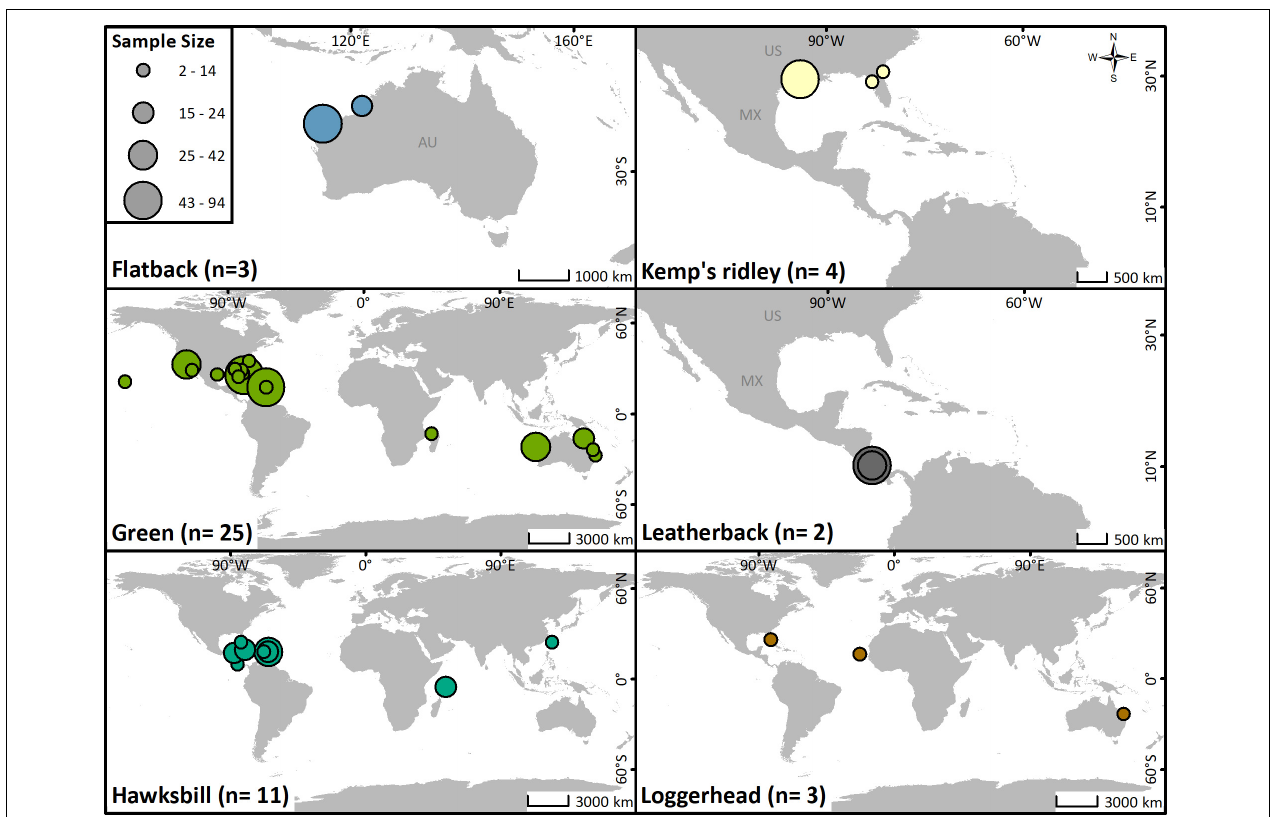
FIGURE 3 | Locations of acoustic telemetry studies for each species of marine turtle, with study sample sizes represented by the size of the